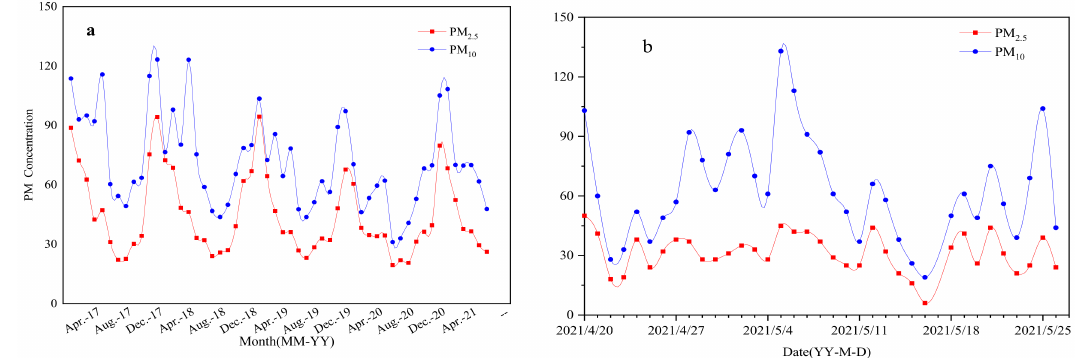
Figure 2. The average monthly concentrations of PM2.5 and PM10 in Wuhan from January 2017 to May 2021 ( a ), and the average daily concentrations of PM2.5 and PM10 in Wuhan from January to May 2021 ( b ), collected from Tianyun big data website